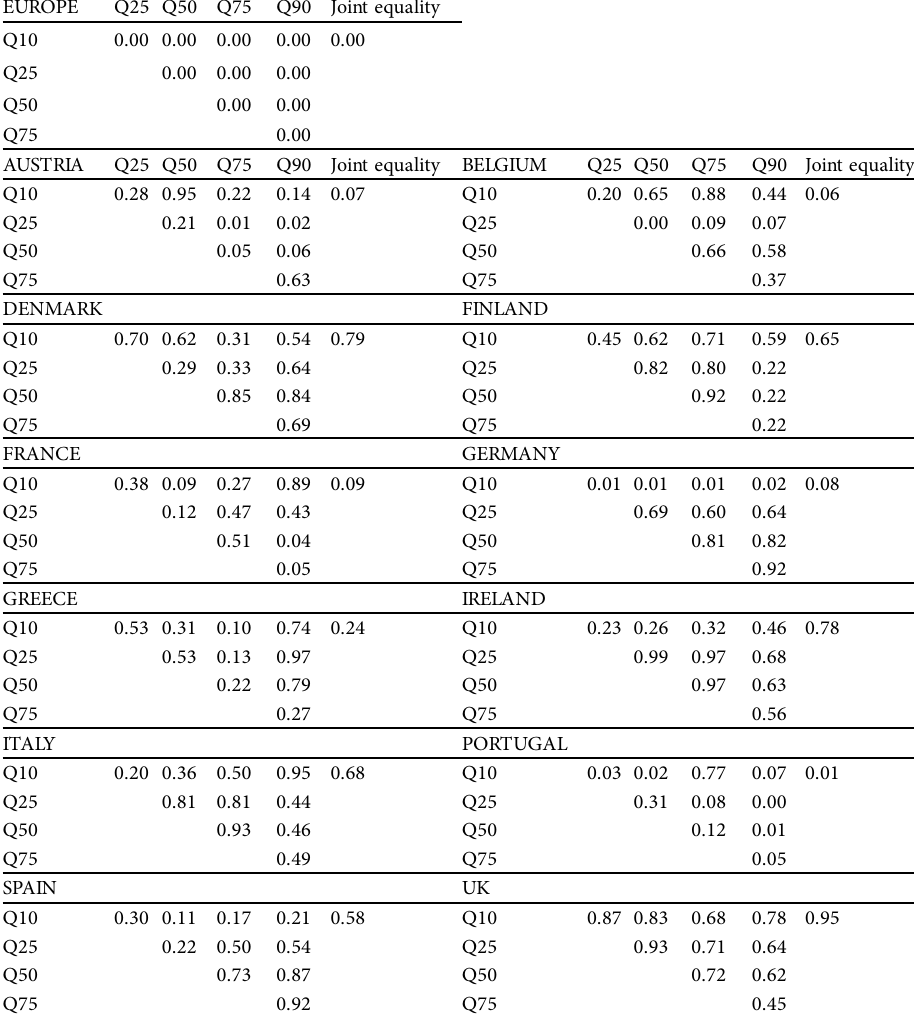
Table 8. Tests for the equality of coefficients at different quantiles (p-values). Skill mismatch